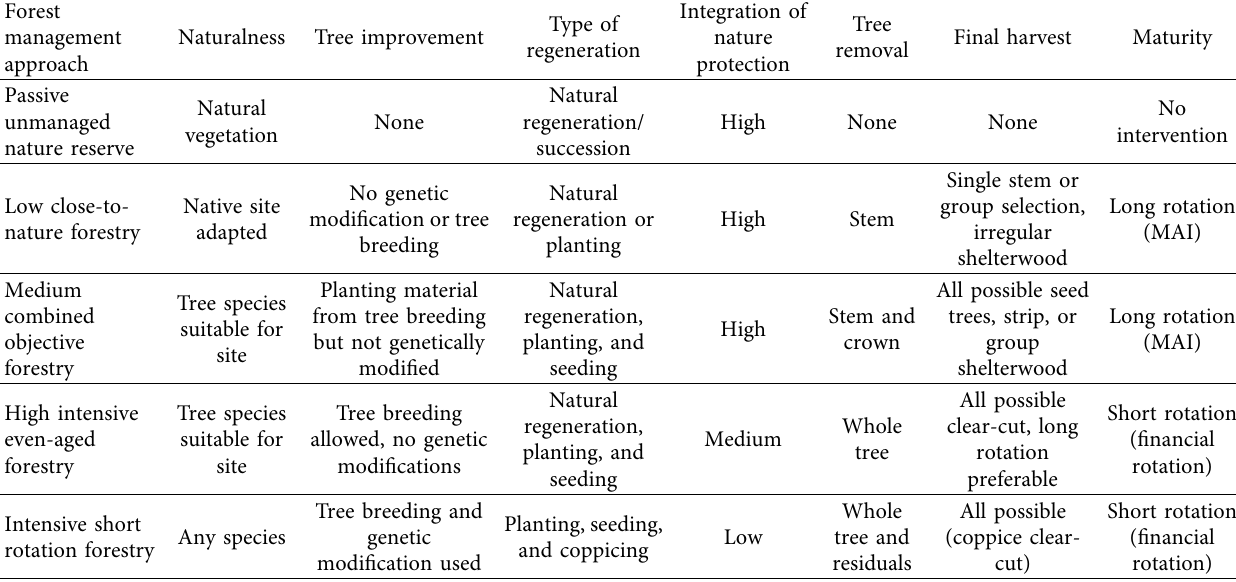
Table 3: Forest management approaches with relevance to deadwood